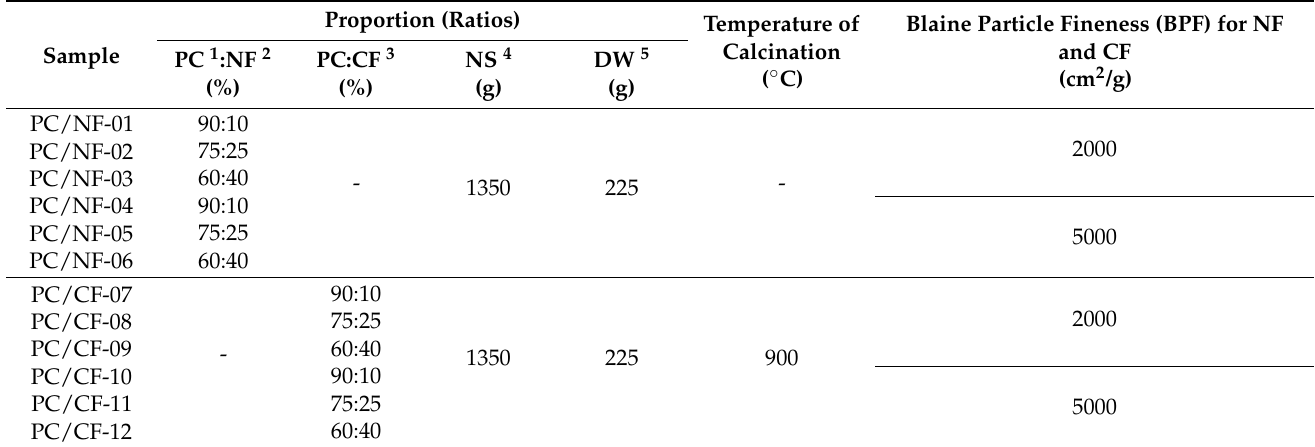
Table 1. Proportions of mixtures of PC, NF, CF and NS used in the preparation of the specimens.